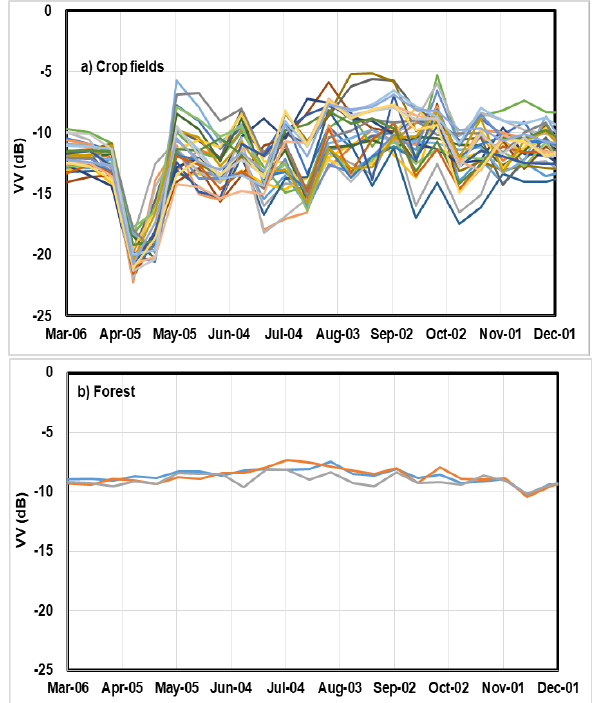
Figure 3. Typical seasonal variation of InSAR coherence for the study area during May 6–December 1 2019: ( a ) crop fields and ( b ) forest.